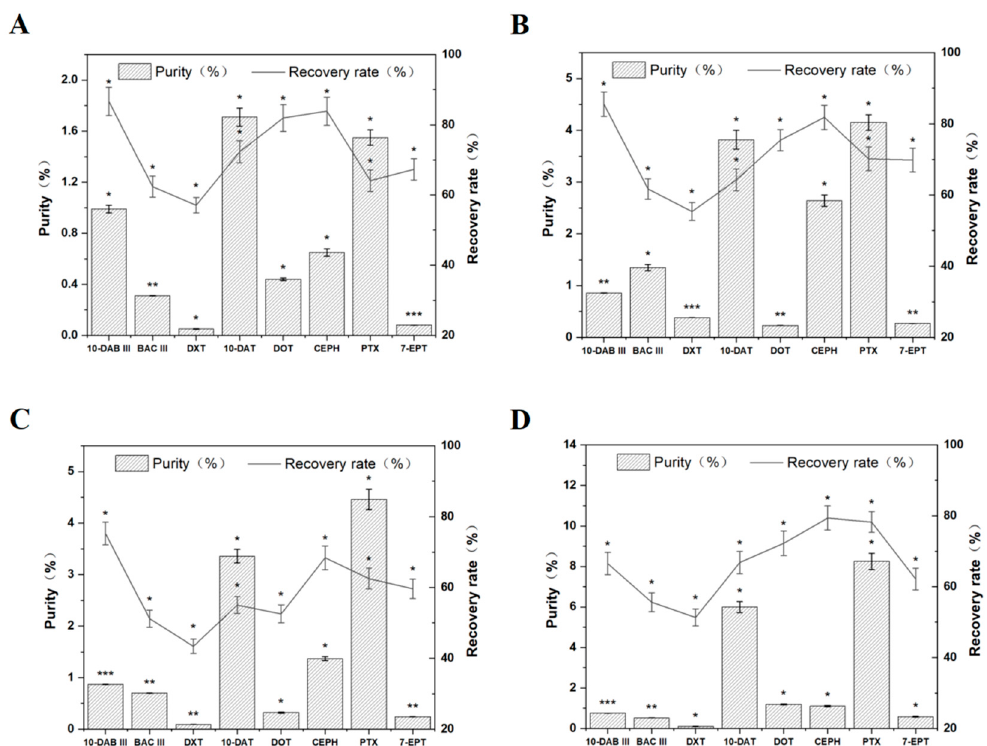
Figure 1. ( A ) Effects of ethyl acetate extraction, ( B ) n-hexane as the antisolvent for recrystallization, ( C ) petroleum ether as the antisolvent for recrystallization, and ( D ) water as the antisolvent for recrystallization on the purity and recovery of taxanes in Taxus cuspidata ( p < 0.05 indicated by *, p < 0.005 indicated by **, and p < 0.001 indicated by ***).